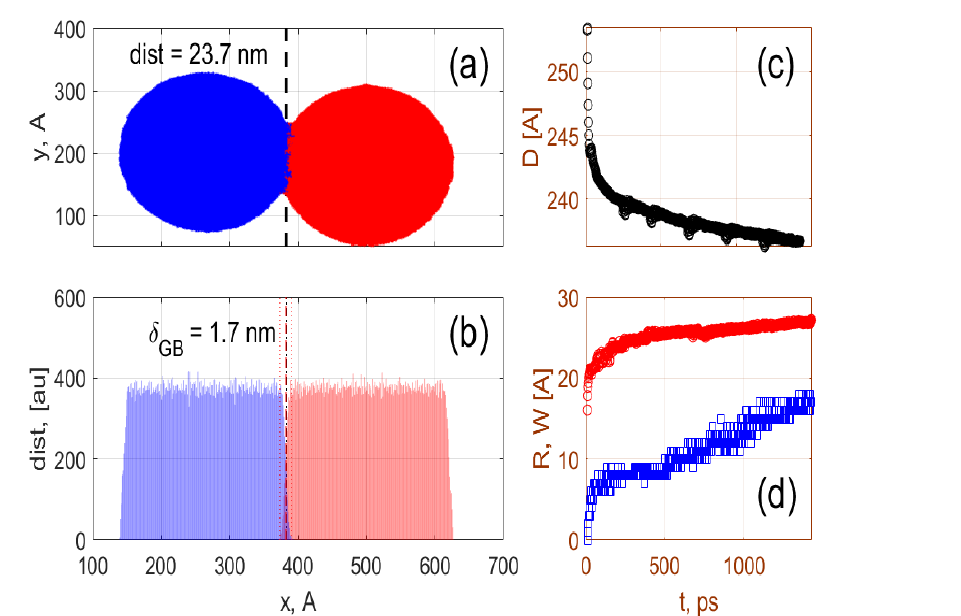
Figure 2. ( a ) Two interacting particles with the interface shown by the vertical dashed line. ( b ) Distribution of titanium atoms in two particles along the x coordinate within a cylinder of radius 5 nm whose axis passes through the centres of both particles. The interface between the particles is shown by the vertical dashed line. ( c ) Distance between particle centres as a function of time. ( d ) The effective grain boundary width (blue squares) and neck radius (red circles) as a function of time. The δ GB is shown by vertical dash-dotted red vertical